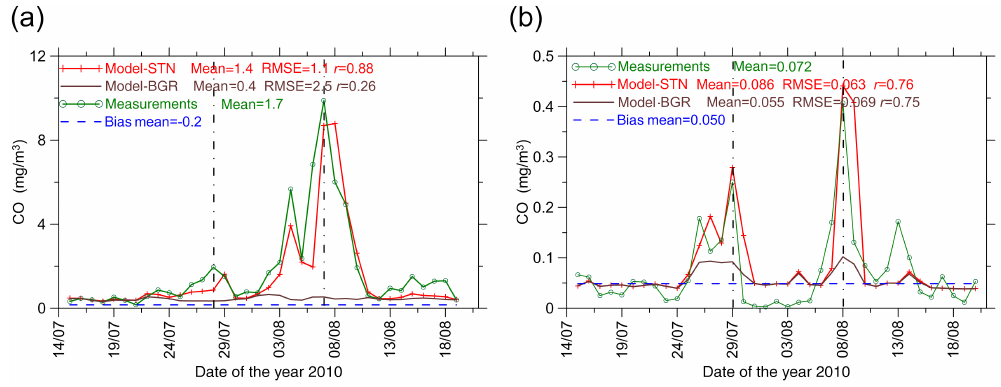
Figure 3. Time series of daily CO concentrations in Moscow (a) and in Kuopio (b) . The CO concentrations for simulation scenario STN (see the red lines with crosses) are obtained by taking into account both anthropogenic and fire emissions (as explained in Sect. 2.8), while that for the BGR run (see the solid brown lines) reflects only anthropogenic CO emissions (along with other sources contributing to the boundary conditions for CO). The dashed blue lines depict the model bias (representing the systematic difference between the simulations and measurements on days not affected by fires); note that a negative bias (specifically, in plot a) is shown with the opposite sign. The measurement data (from Mosecomonitoring stations and the Maaherrankatu site in Kuopio) are shown by green lines. The vertical dashed lines indicate the CO concentrations observed (a) in Moscow on 28 July and 7 August and (b) in Kuopio on 29 July and 8 August.